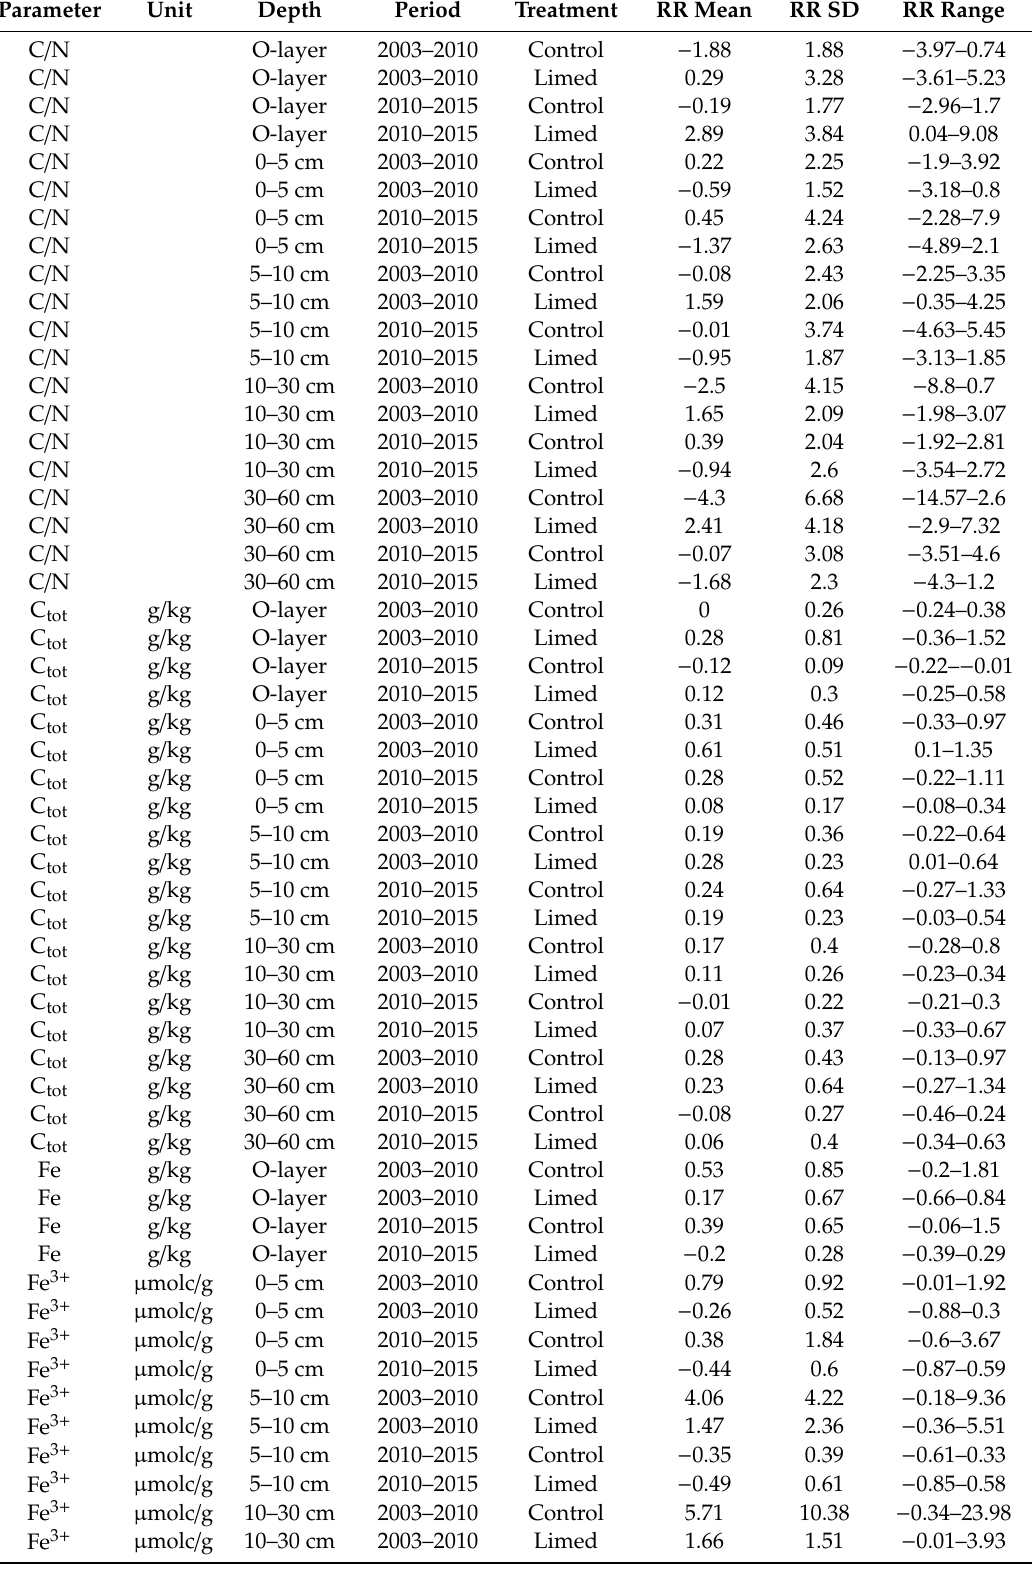
Table A3. G1 study site parameter pH-KCl, Mg, K, Na, Fe, Mn, H, C and N response ratios (RR) to time in